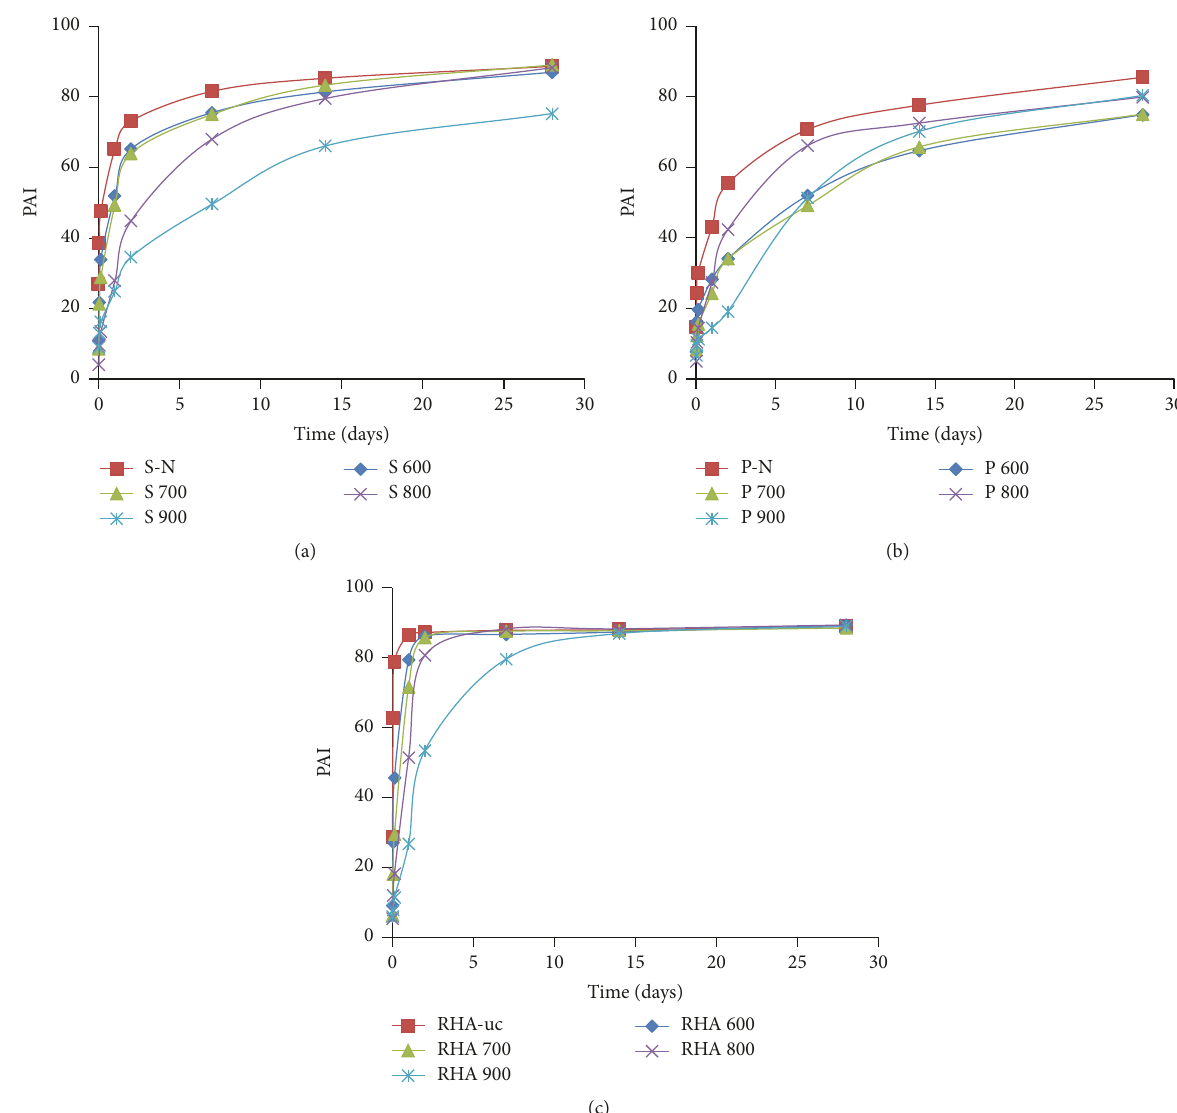
Figure 3: PAI versus reaction time: (a) scoria, (b) pumice, and (c)